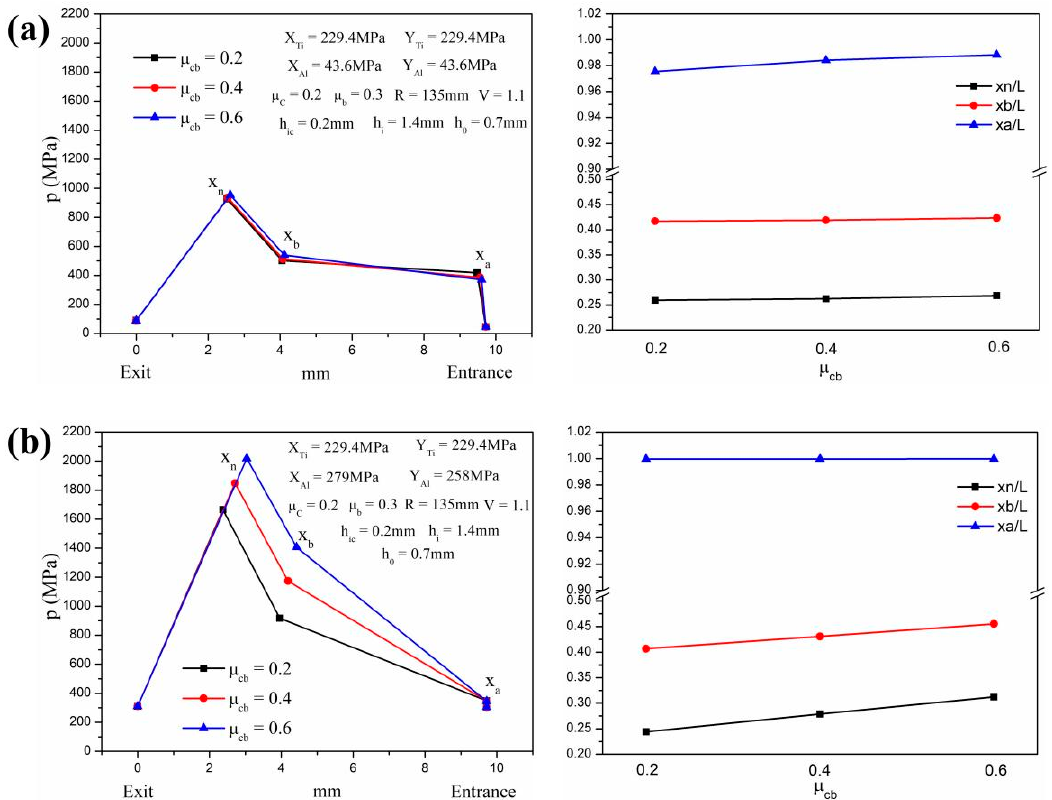
Figure 13. Effect of friction coefficient between titanium and aluminum on the stress distribution, x a , x , x and x , in the deformation zone. ( a ) S1, ( b ) S3.